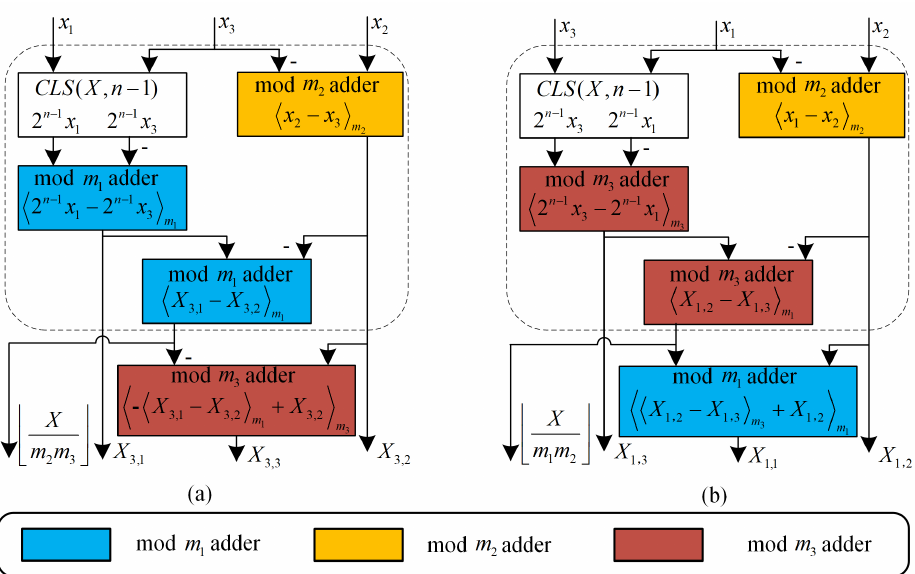
Figure 4. Scaling structures of four scaling factors. ( a ) scaling factor 2 n + 1 and 2 n ( 2 n + 1 ) joint scaling structure; ( b ) scaling factor 2 n − 1 and 2 n ( 2 n − 1 ) joint scaling